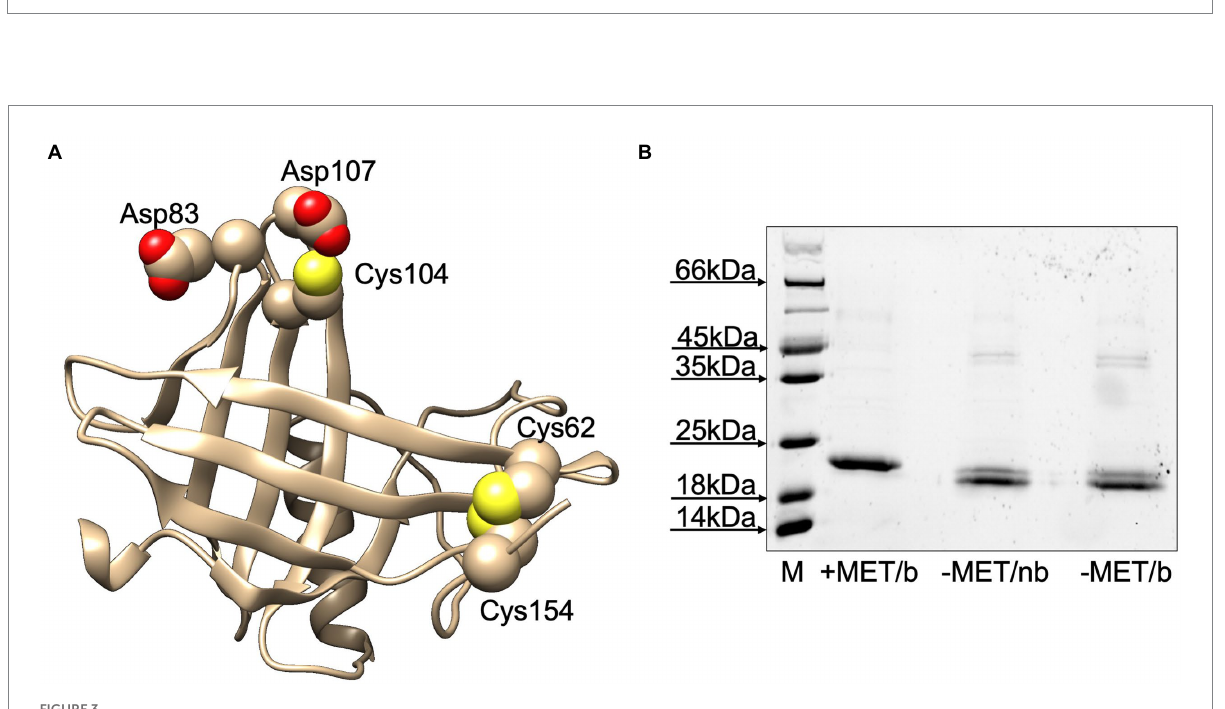
FIGURE 3 (A) Three-dimensional model of LafrOBP2. The model was built using the on-line software Swiss Model (Bertoni et al., 2017; Waterhouse et al., 2018; Studer et al., 2021) and the human OBP2a crystal structure (PDB: 4run.2.A; identity: 50%) as a template. Cysteines are shown in space-filling mode. Figures were created with Chimera software (Pettersen et al., 2004). (B) Test for the presence of dimer LafrOBP2. Aliquots of the protein were treated with sample buffer with (+) or without ( − ) mercaptoethanol (MET) and boiled (b) or not boiled (nb), then analysed by SDS-PAGE. All three samples mainly migrate with the same apparent molecular mass, thus excluding the presence of a covalent dimer in significant